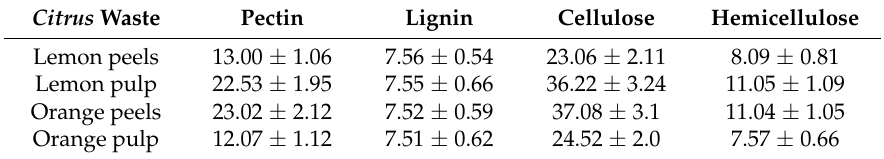
Table 1. Fibre composition (% dry weight) of different citrus fruit by-products. Adapted from Mar í n et al. [3]. Citrus Waste Pectin Lignin Cellulose Hemicellulose Lemon peels